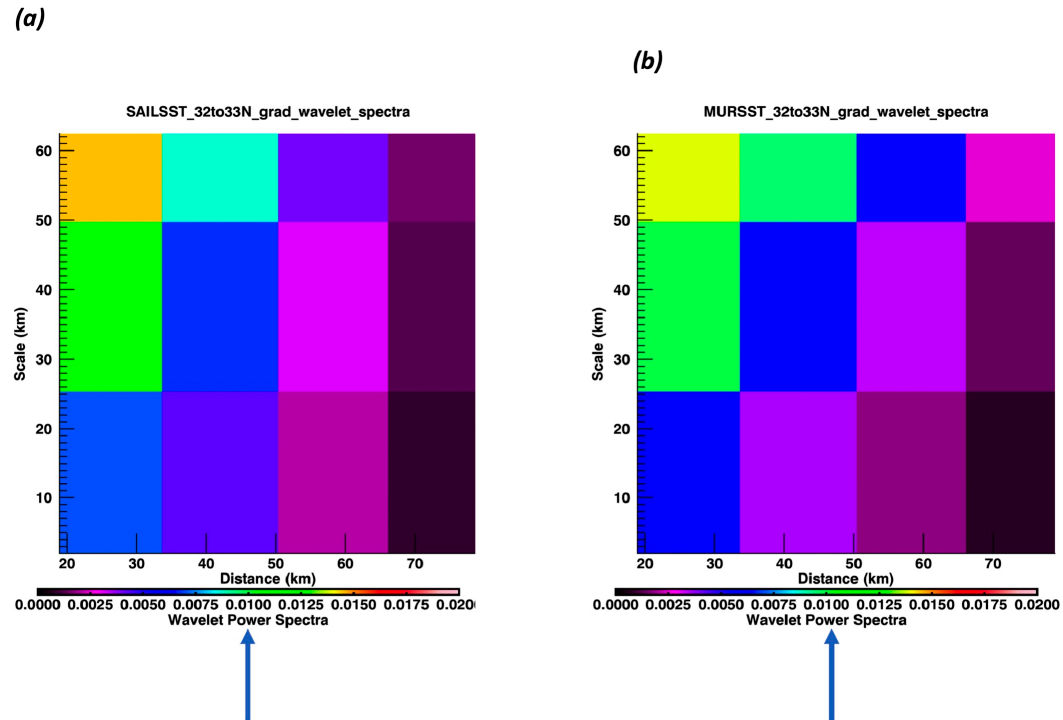
Figure 5. ( a , b ). Wavelet spectra from 32°N to 33°N for ( a ) SAILSST and ( b ) MURSST. Arrows indi- Figure 5. ( a , b ): Wavelet spectra from 32 ◦ N to 33 ◦ N for ( a ) SAILSST and ( b ) MURSST. Arrows indicate cate the color associated with the 95% level of confidence. the color associated with the 95% level of confidence.